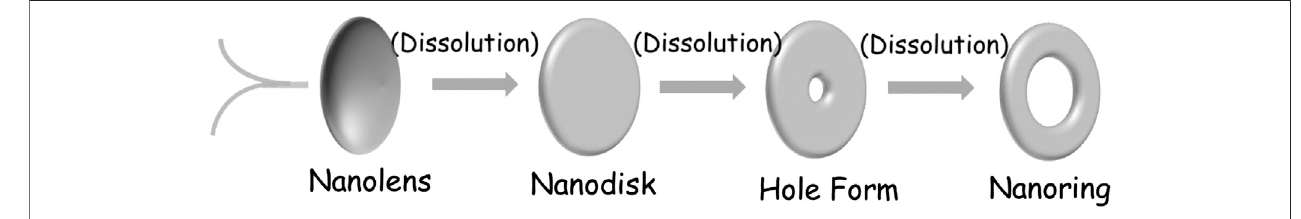
FIGURE 3 | Schematic illustration of V 2 O 3 nanoring formation.